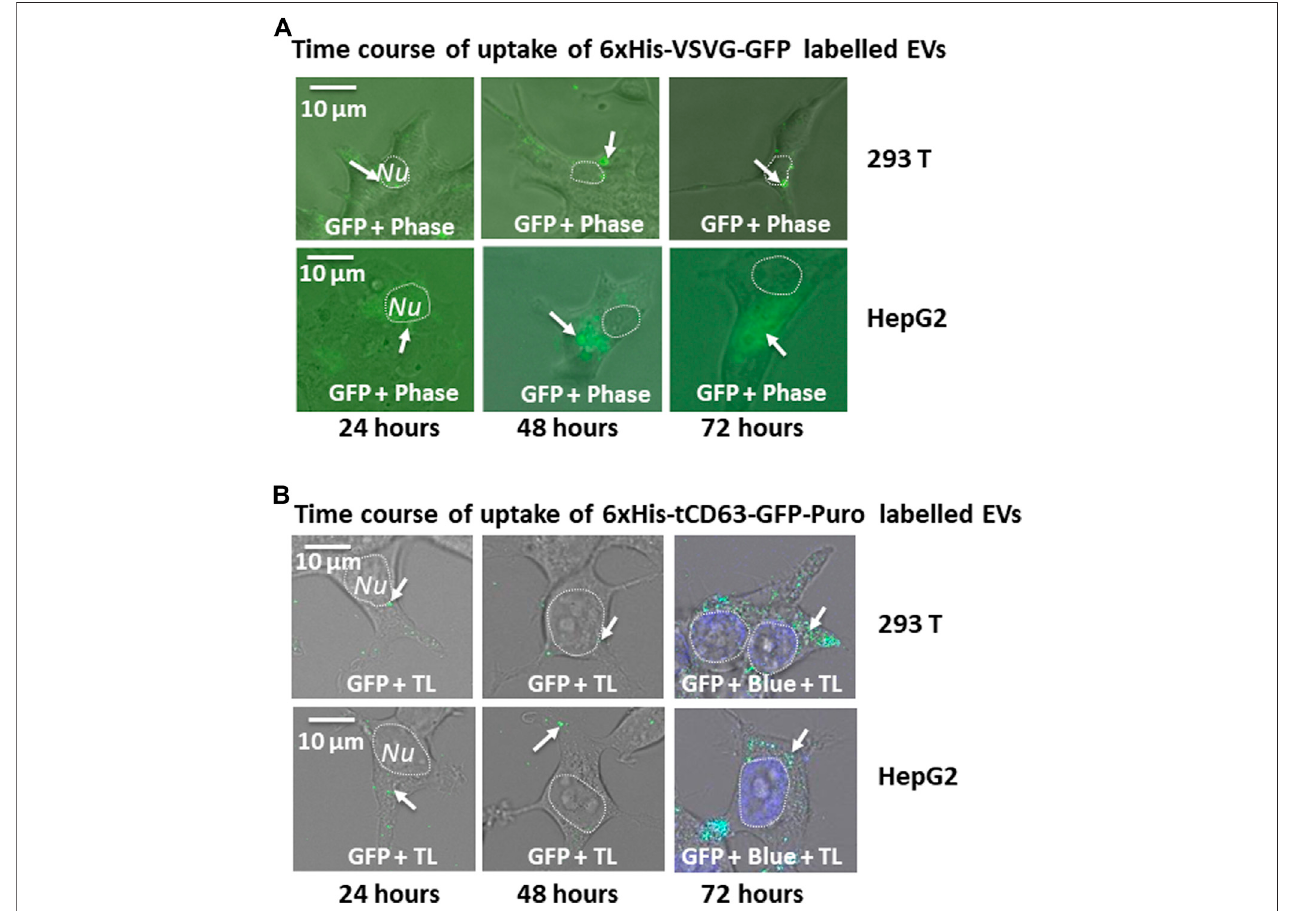
FIGURE 5 | Time-course study of EVs uptake by various mammalian cells. Cellular uptake of dual-tagged EVs in various cultured mammalian cell types. Cultured cells were treated with either 6xHis-VSVG-GFP EVs (A) or 6xHis-tCD63-GFP-Puro EVs (B) for up to 72 h Images were recorded at indicated time points (24, 48, and 72 h) post-transfection with both fl uorescent/confocal and phase contrast/transmitted light (TL) for 293T (right panels) or HepG2 (left panels). Arrows indicate endosome/exosome/MVB structures. Dashed circle indicates nucleus ( Nu ). Scale bar, 10 µm. TL, transmitted light. Blue, DAPI staining.